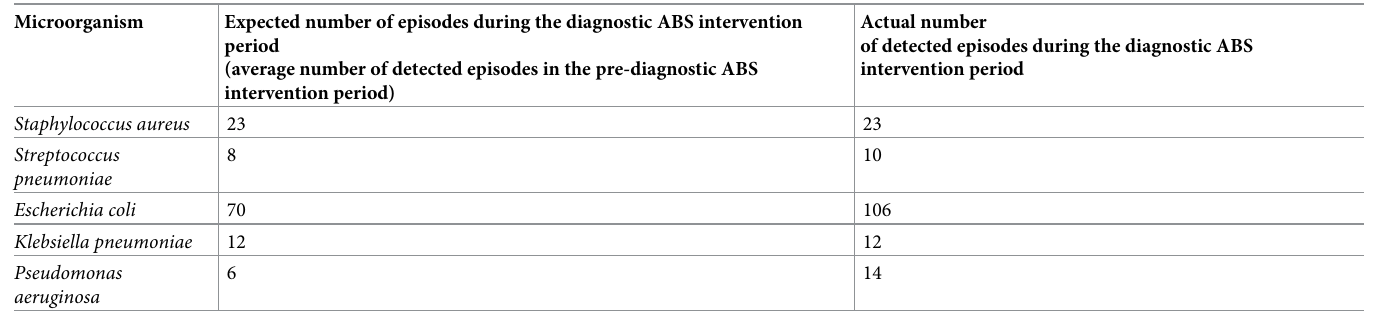
Actual number of detected episodes during the diagnostic